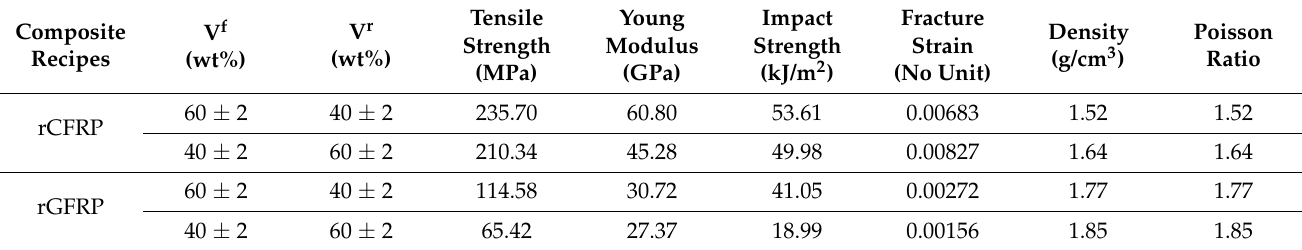
Table 1. Mechanical properties of the produced rCFRP and rGFRP composites